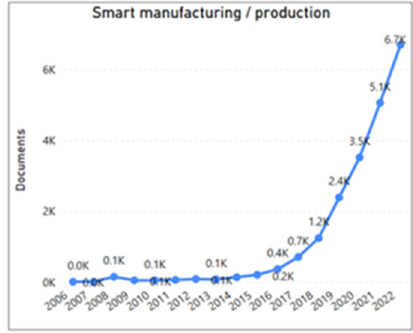
Figure 4. Smart manufacturing/production systems—years 2006–2022, 20,812 documents in period.